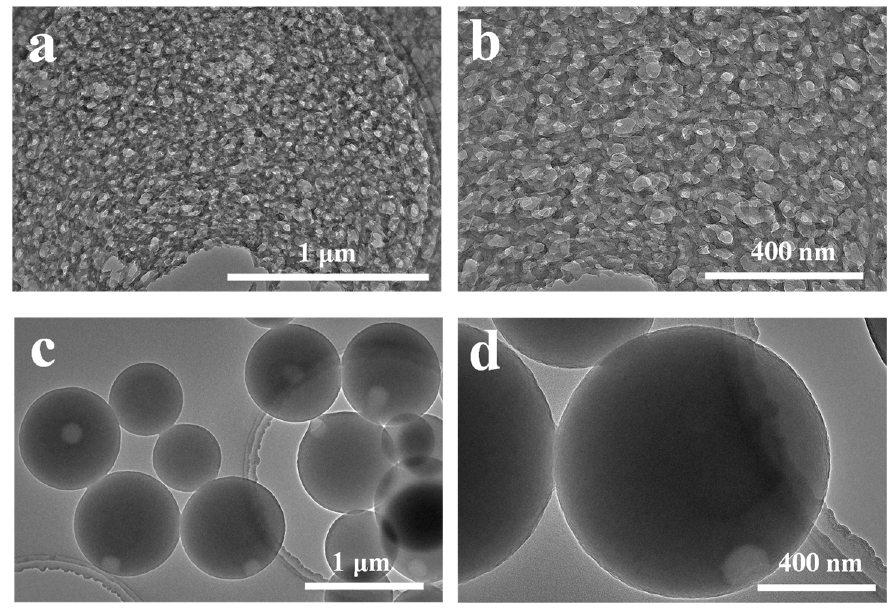
Figure 7. TEM images recorded for LNPs: ( a , b ) TLNP; ( c , d ) CLMP.